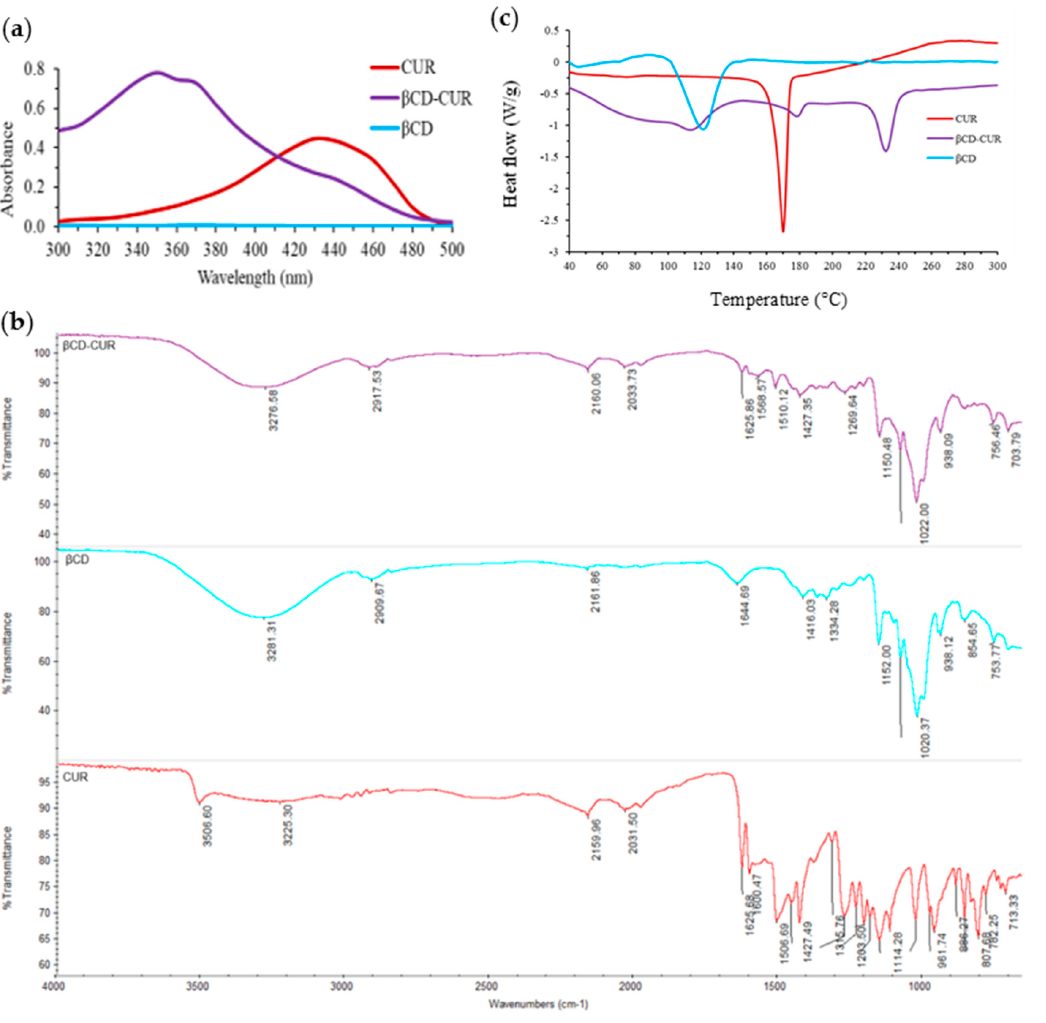
Figure 1. ( a ) Absorption spectra of CUR, β CD, and β CD-CUR inclusion complexes under a wave- length range of 300–500 nm. ( b ) Fourier transform infrared spectra (4000–1000 cm − 1 ). ( c ) Differential thermal analysis exothermic curves.